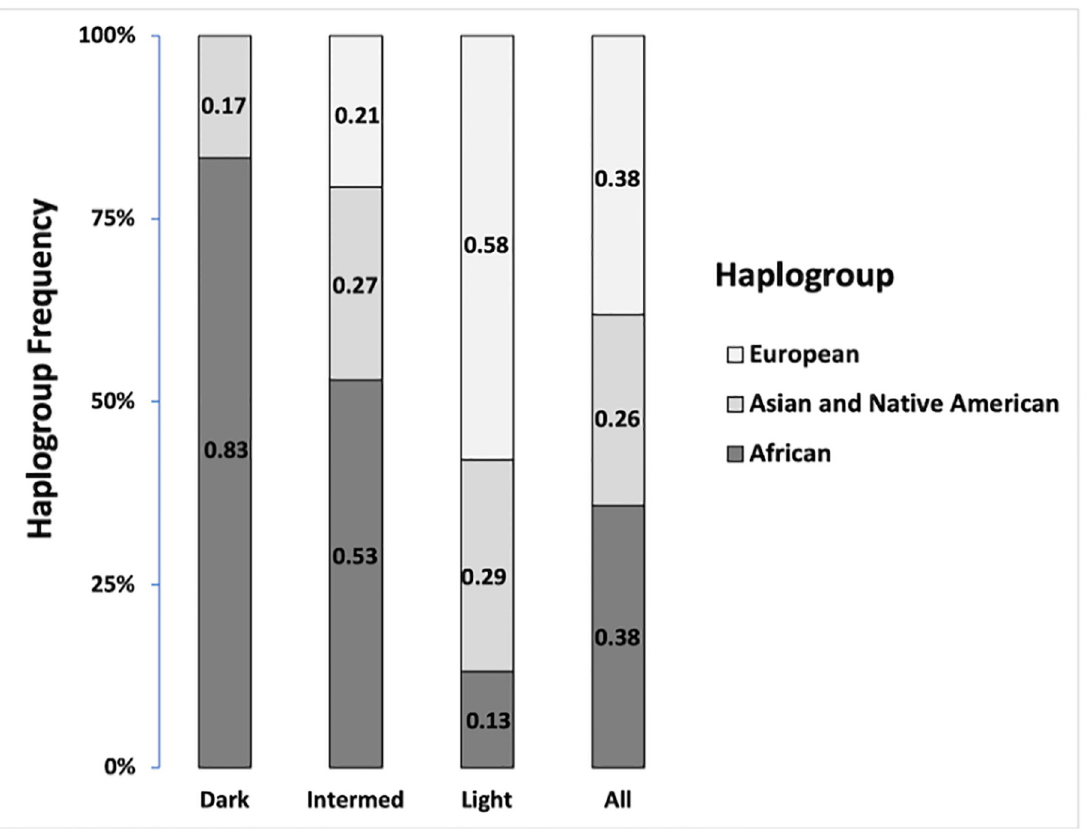
Fig 3. Distribution of matrilineal lineages among individuals of skin color variation in the population of RJ. Haplogroups based on the HVS-I region of Mitochondrial DNA were classified using Haplogrep software. The numbers correspond to the frequency of African, Asian, Native American and European haplogroups within color phenotypes: Dark, intermediate and light. All represents the frequency distribution of matrilineal lineages of all skin color variation in our sample.